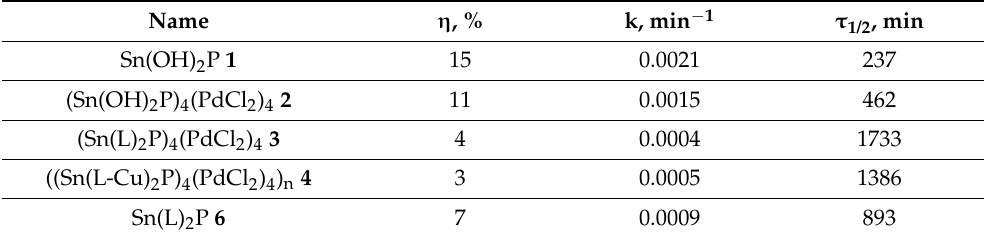
Table 9. Experimental data of the objects of study after a session of UV light irradiation after 75 min ( λ = 415 nm) in DMSO.